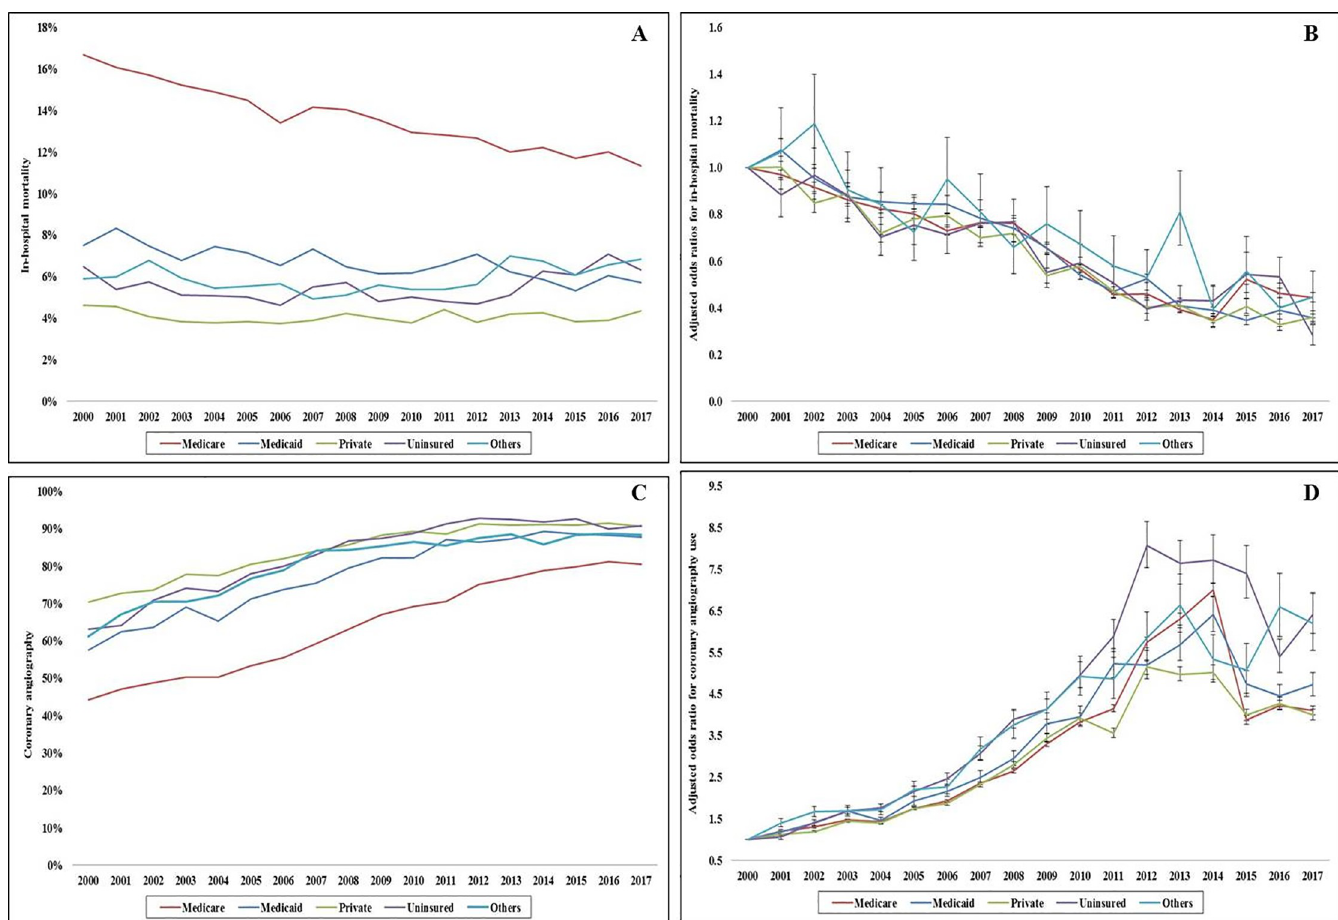
Fig 1. Temporal trends of coronary angiography use and in-hospital mortality in STEMI admissions stratified by insurance status. A : 18-year unadjusted trends of in-hospital mortality in STEMI admissions; p < 0.001 for trend over time; B : Adjusted multivariate logistic regression for temporal trends of in-hospital mortality in STEMI admissions (2000 as referent year) � ; p < 0.001 for trend over time; C: 18-year unadjusted trends of coronary angiography use in STEMI; all p < 0.001 for trend over time; D : Adjusted multivariate logistic regression for temporal trends of coronary angiography use in STEMI admissions (2000 as referent year) �� ; p < 0.001 for trend over time; � Adjusted for age, sex, race, socio-economic stratum, hospital characteristics, comorbidities, year of admission, STEMI location, cardiogenic shock, cardiac arrest, acute respiratory failure, acute kidney injury, systolic heart failure, prior CABG, complications, cardiac procedures, non-cardiac procedures, DNR status and palliative care referral; �� Adjusted for age, sex, race, socio-economic stratum, hospital characteristics, comorbidities, year of admission, STEMI location, cardiogenic shock, cardiac arrest, do-not-resuscitate (DNR) status and palliative care referral; Abbreviations: STEMI: ST-segment elevation myocardial infarction.